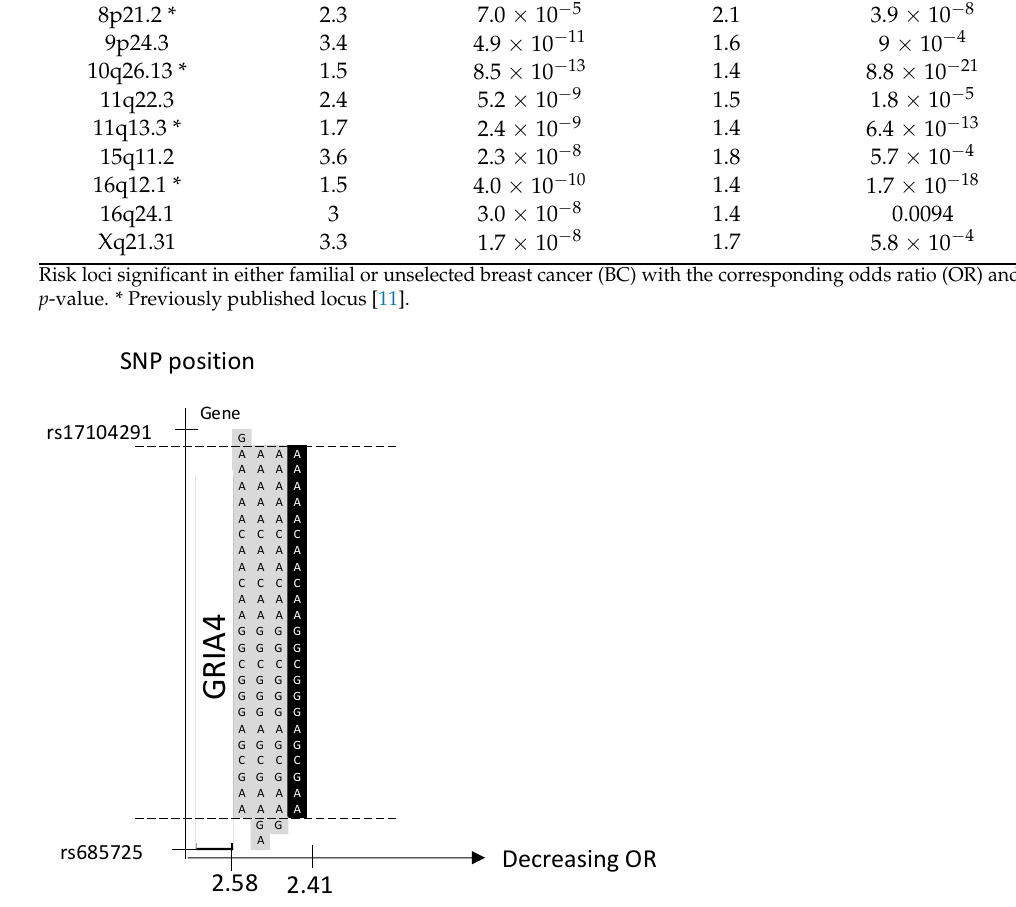
Figure 2. Chromosome 11, one significant haplotype and three borderline significant haplotypes sorted by OR. The significant haplotype is marked in black and borderline significant in light gray. SNP position is on the y -axis. Gene position for GRIA4 is indicated along the y -axis. The corresponding OR is on the x -axis. The dashed lines indicate the proximal and distal SNP that are shared by the significant and borderline significant haplotypes.